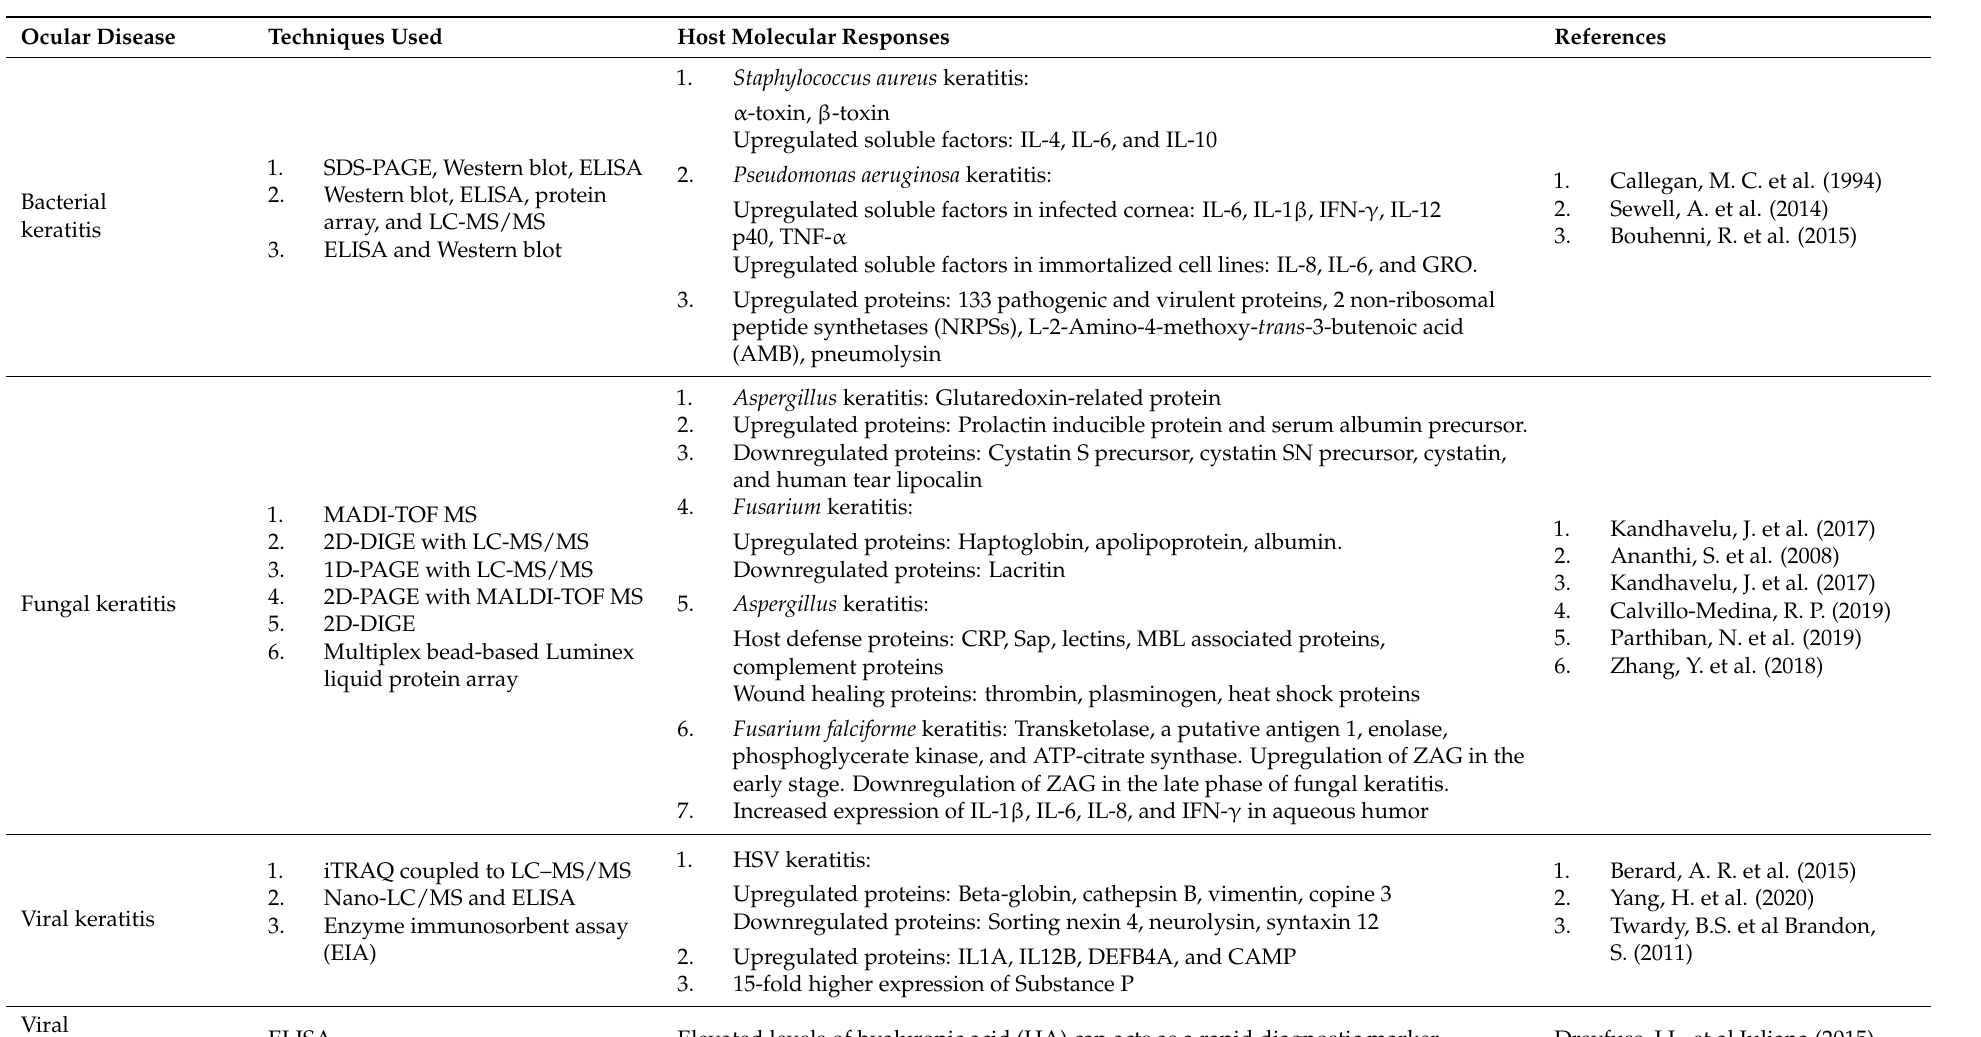
Table 2. Host response proteins in ocular microbial